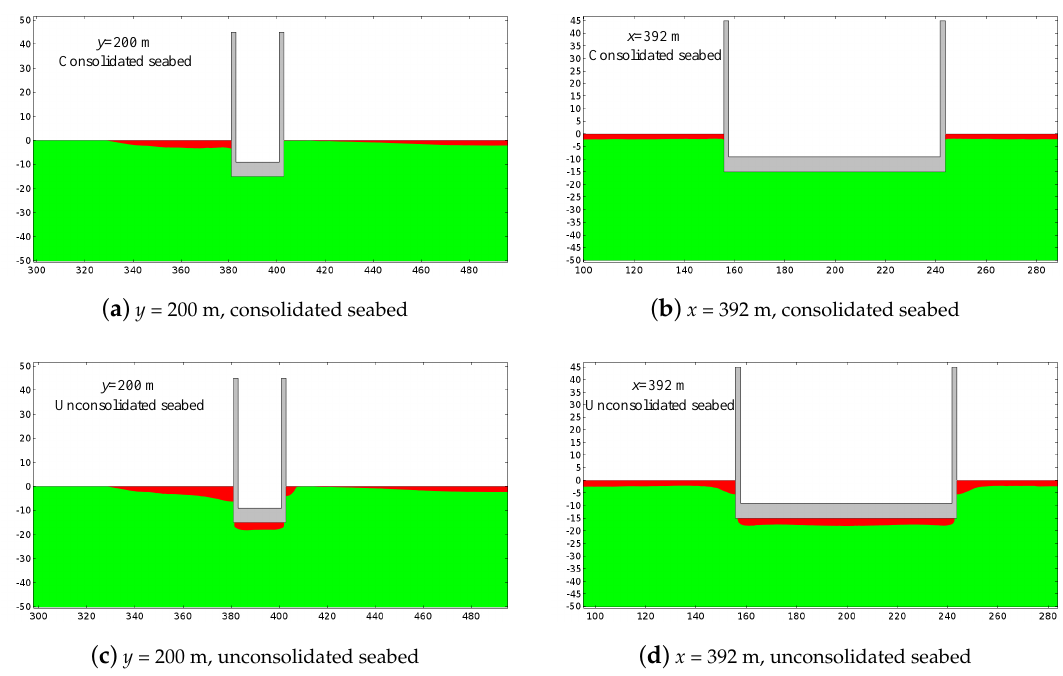
Figure 18. Section view of liquefaction evolution with and without considering consolidation (the red zone is liquefied) within a coarse seabed for Type 33 at t = 83.5 s.